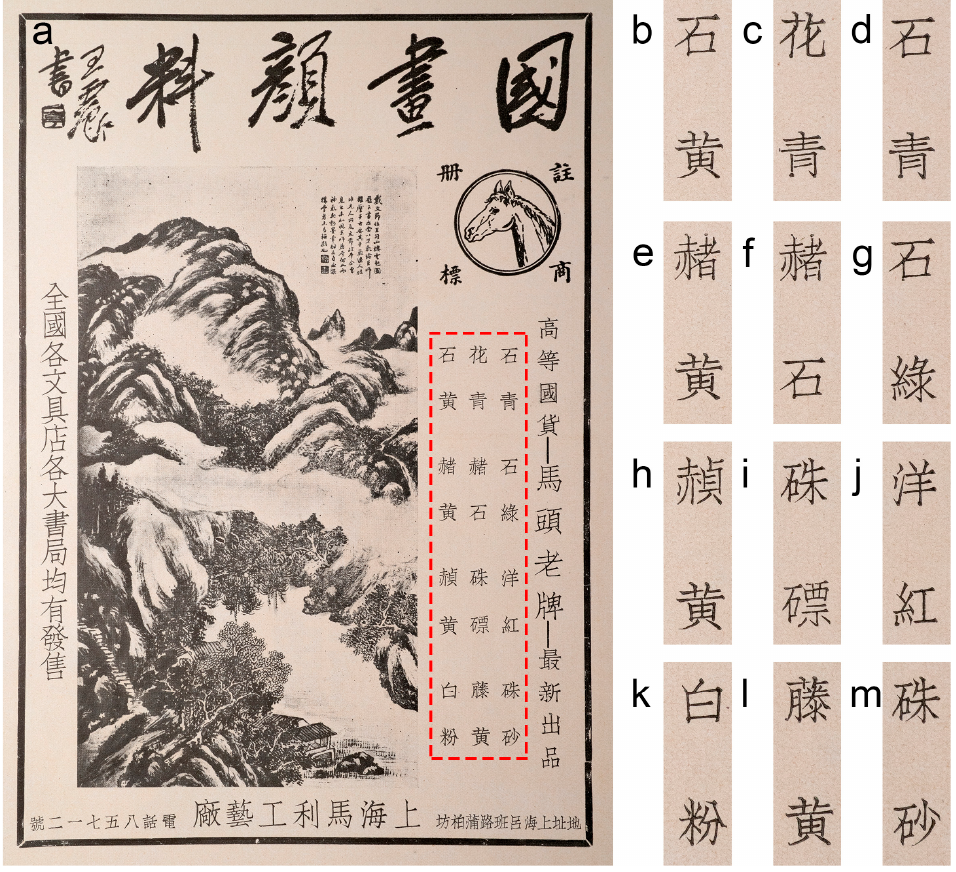
Figure 4. Advertisement by Marie from 1934 with marked listing of 12 pigments ( a ) and corresponding details of the Chinese characters referring to orpiment ( b ), indigo ( c ), azurite ( d ), yellow ochre ( e ), burnt ochre ( f ), malachite ( g ), organic red ( h ), vermillion ( i ), carmine ( j ), white powder ( k ), gamboge ( l ) and cinnabar ( m ).